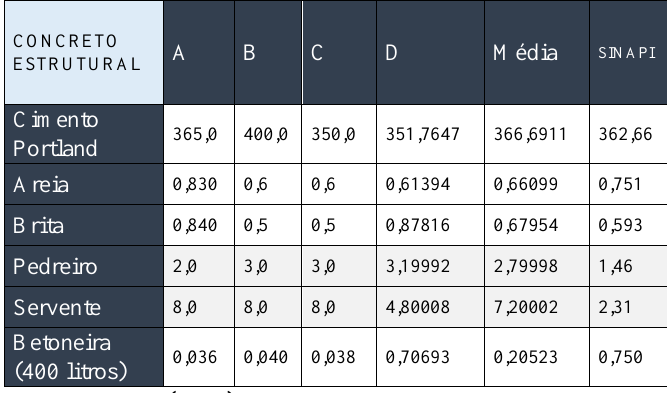
Tabela 1: Índices do serviço de produção de concreto.